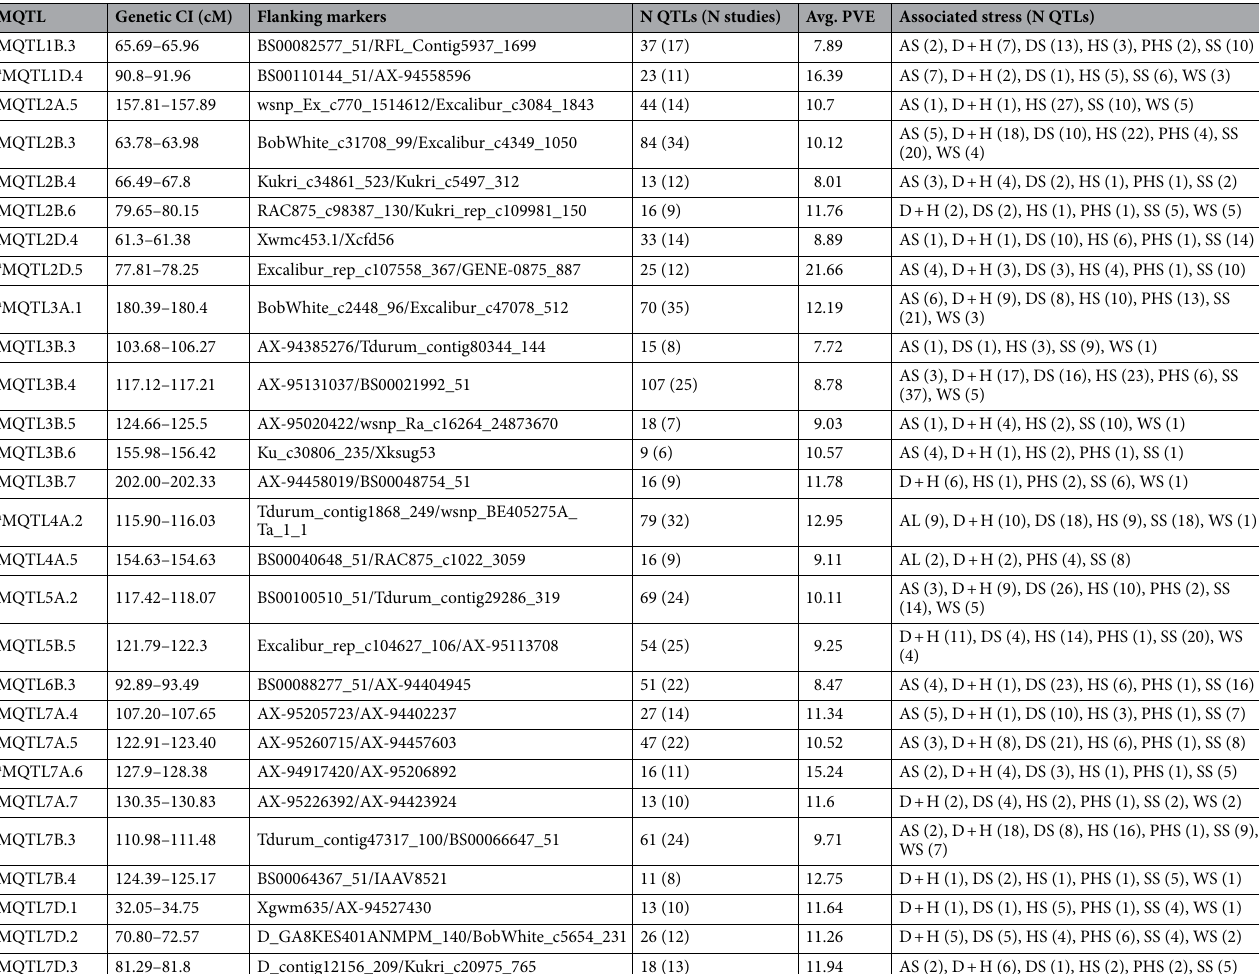
Table 1. MQTLs providing tolerance to five or all six stresses under study. a Promising MQTLs selected for breeding